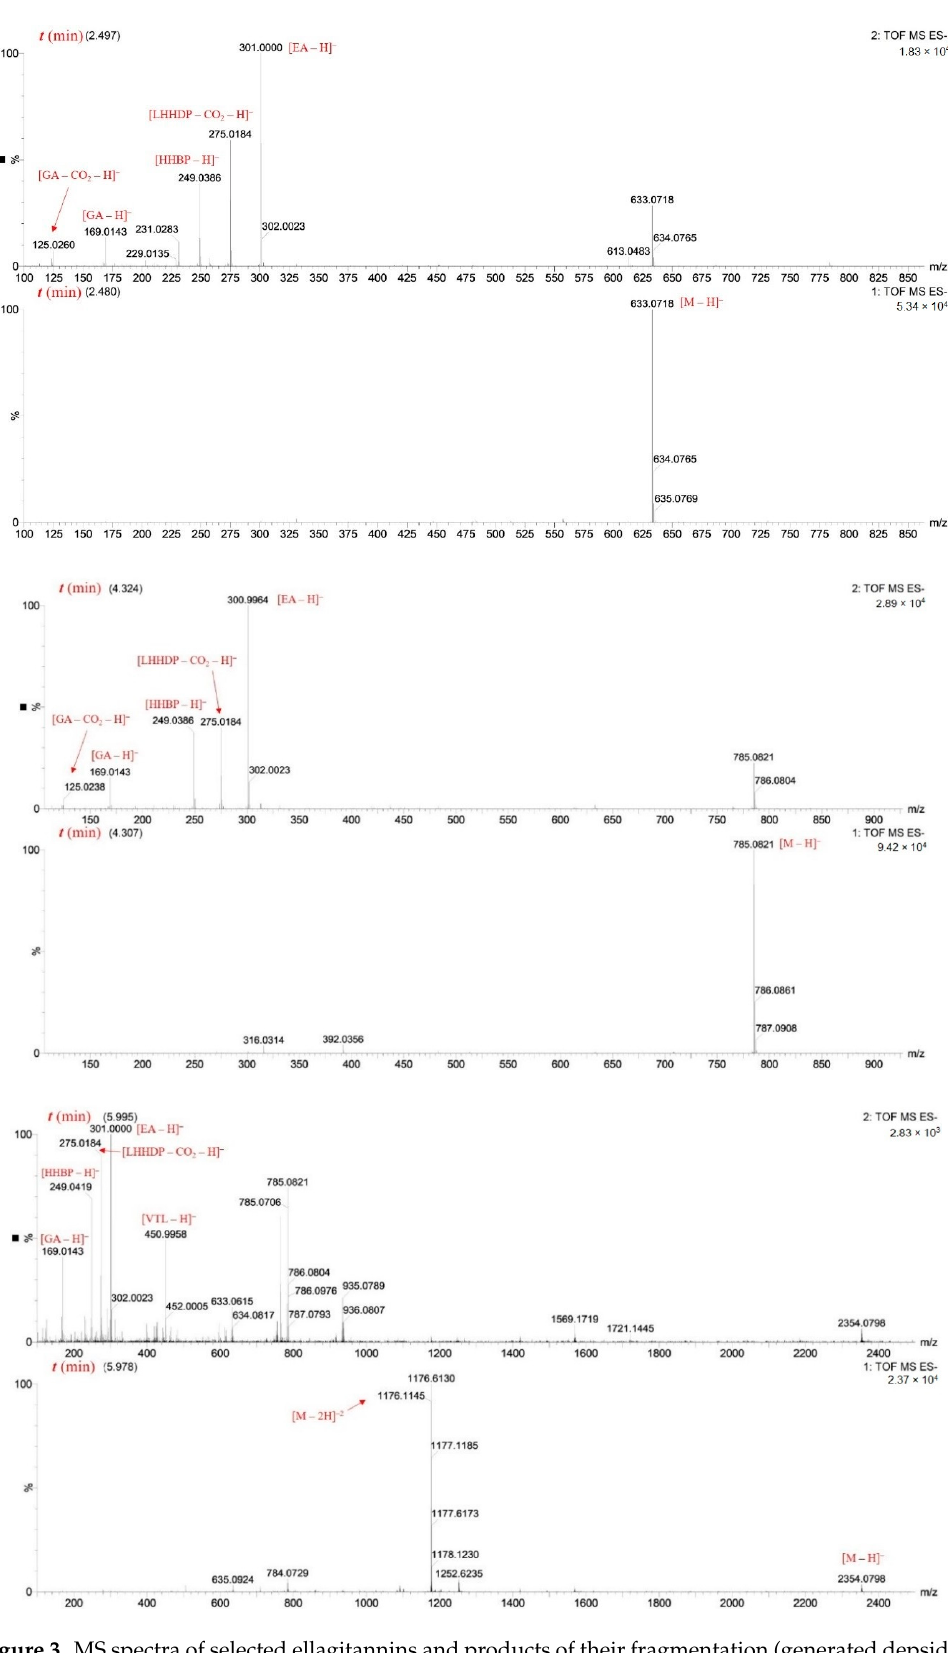
Figure 4. Products of the fragmentation of ellagitannins (depsides). Abbreviations: EA, ellagic acid; LHHDP,